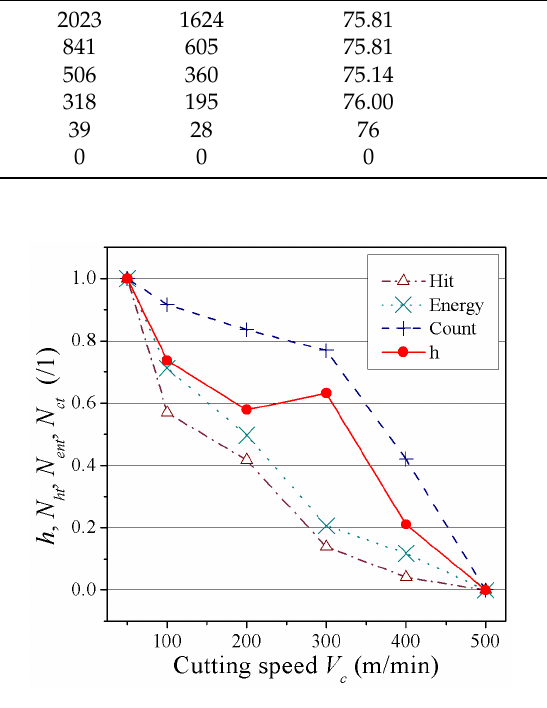
Figure 15. Relation of AE cluster parameters and splintering depth.